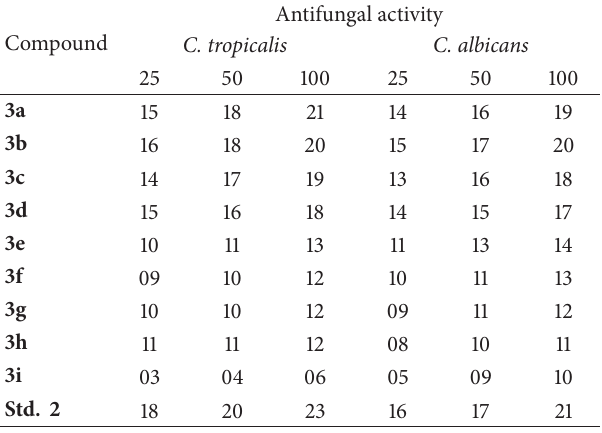
Std. 2: Fluconazole.